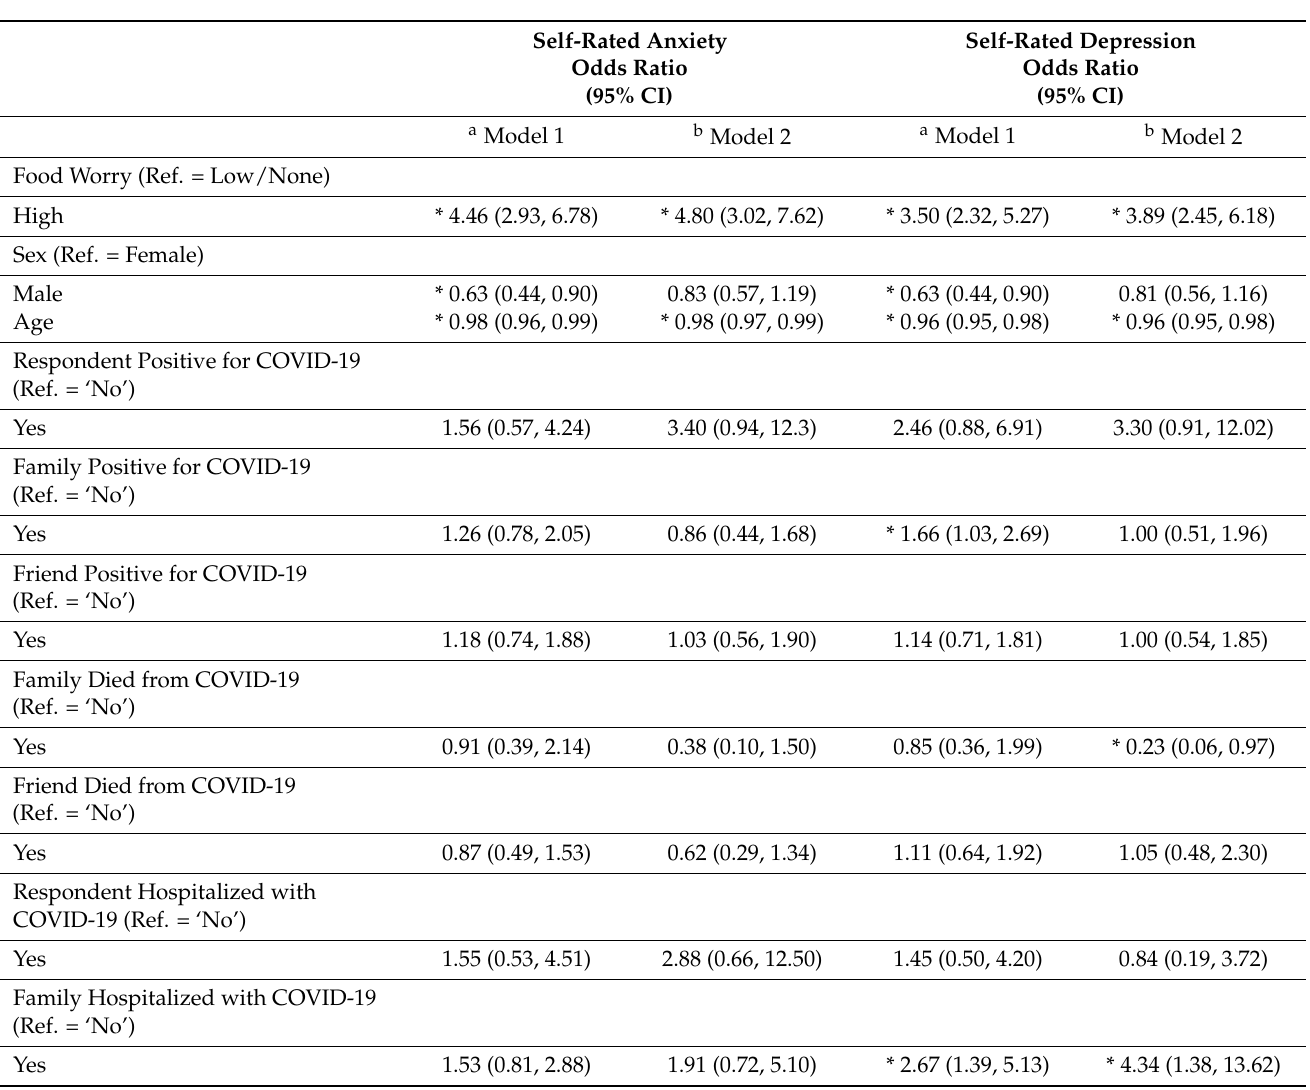
Table 3. Crude and adjusted associations between food worry and mental health outcomes during COVID-19, New York, United States. Self-Rated Anxiety Odds Ratio (95%